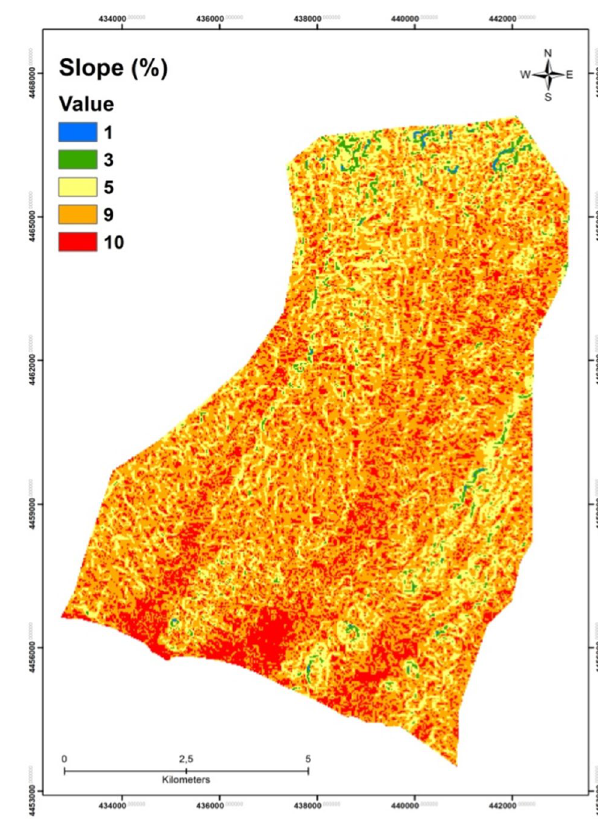
Fig. 3 Soil media of the study area